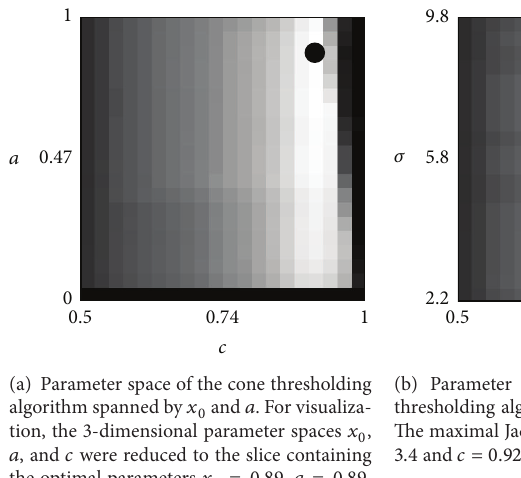
(c) Parameter space of gray-level thresholding spanned by 𝑡 spec and 𝑐 . The maximum Jaccard index is labeled by the red dot. 𝑡 spec = 0.94 and 𝑐 = 0.92